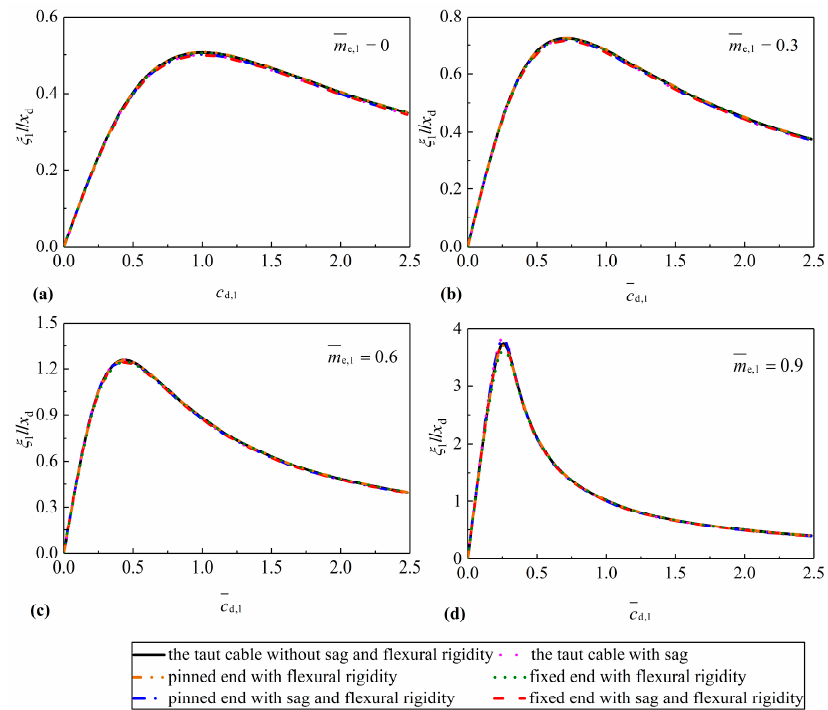
Figure 4. The first supplemental modal damping ratio of the short cable versus damping coefficient for various inertial masses: ( a ) m e,1 = 0; ( b ) m e,1 = 0.3; ( c ) m e,1 = 0.6; ( d ) m e,1 = 0.9.